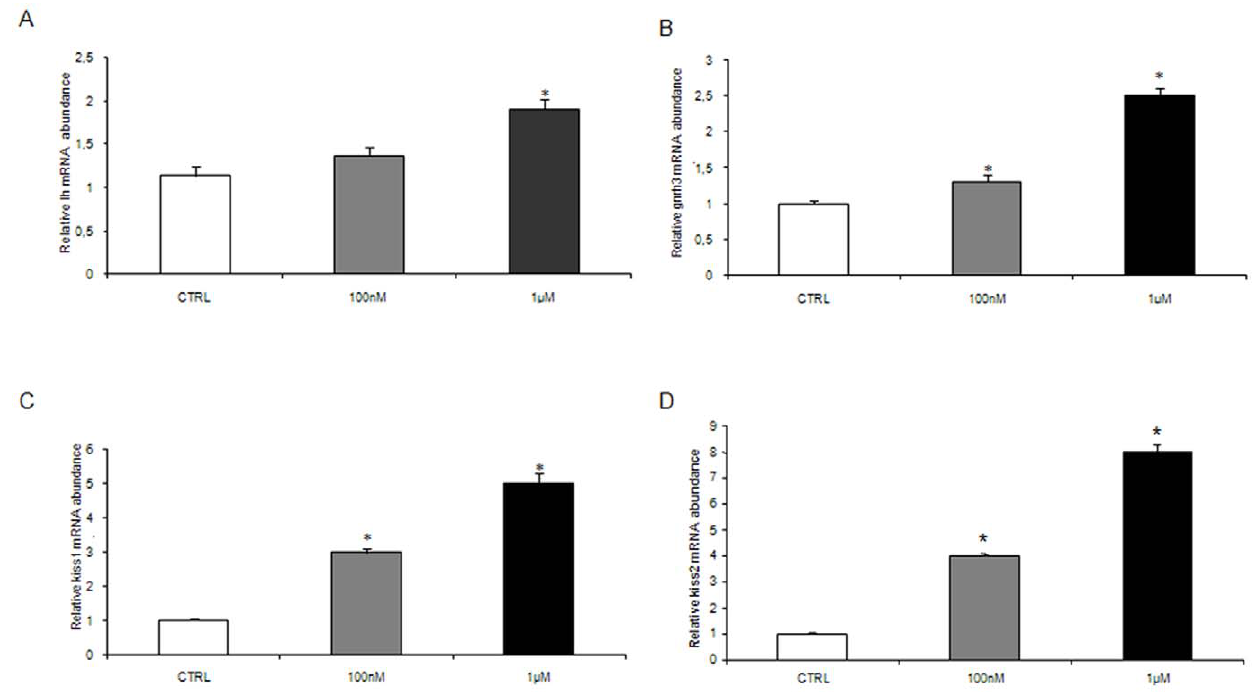
Figure 1. Effects of melatonin in the brain and pituitary. (A) kiss1 , (B) kiss2 (C) gnrh3 and (D) lh mRNA levels, normalized against b -actin gene in fish exposed to 100 nM and 1 m M MEL, n=15 per group. Error bars indicate mean 6 S.D. Asterisks denote exposure groups that are significantly different from the relative control group (CTRL) (p , 0.05), analyzed using ANOVA followed by Bonferroni’s multiple comparison test.